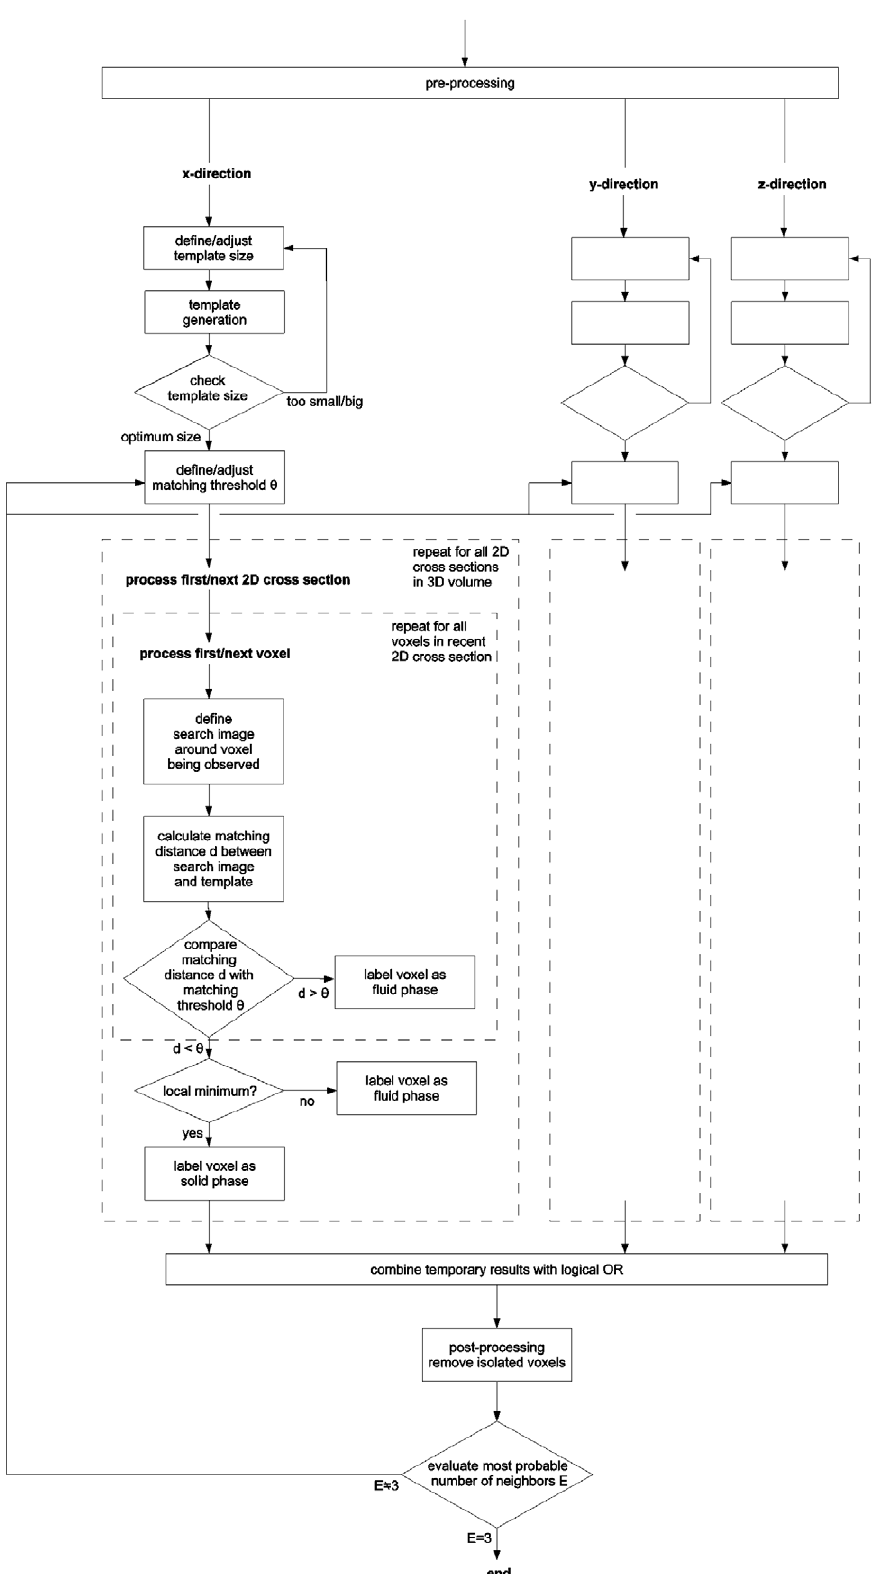
Figure 5. Flow chart of the reconstruction algorithm. The method involves three independent 2D scans through the 3D image stack, along the x-, y- and z-directions. Since these scans are analogous, the diagram focuses on the x-scan only.